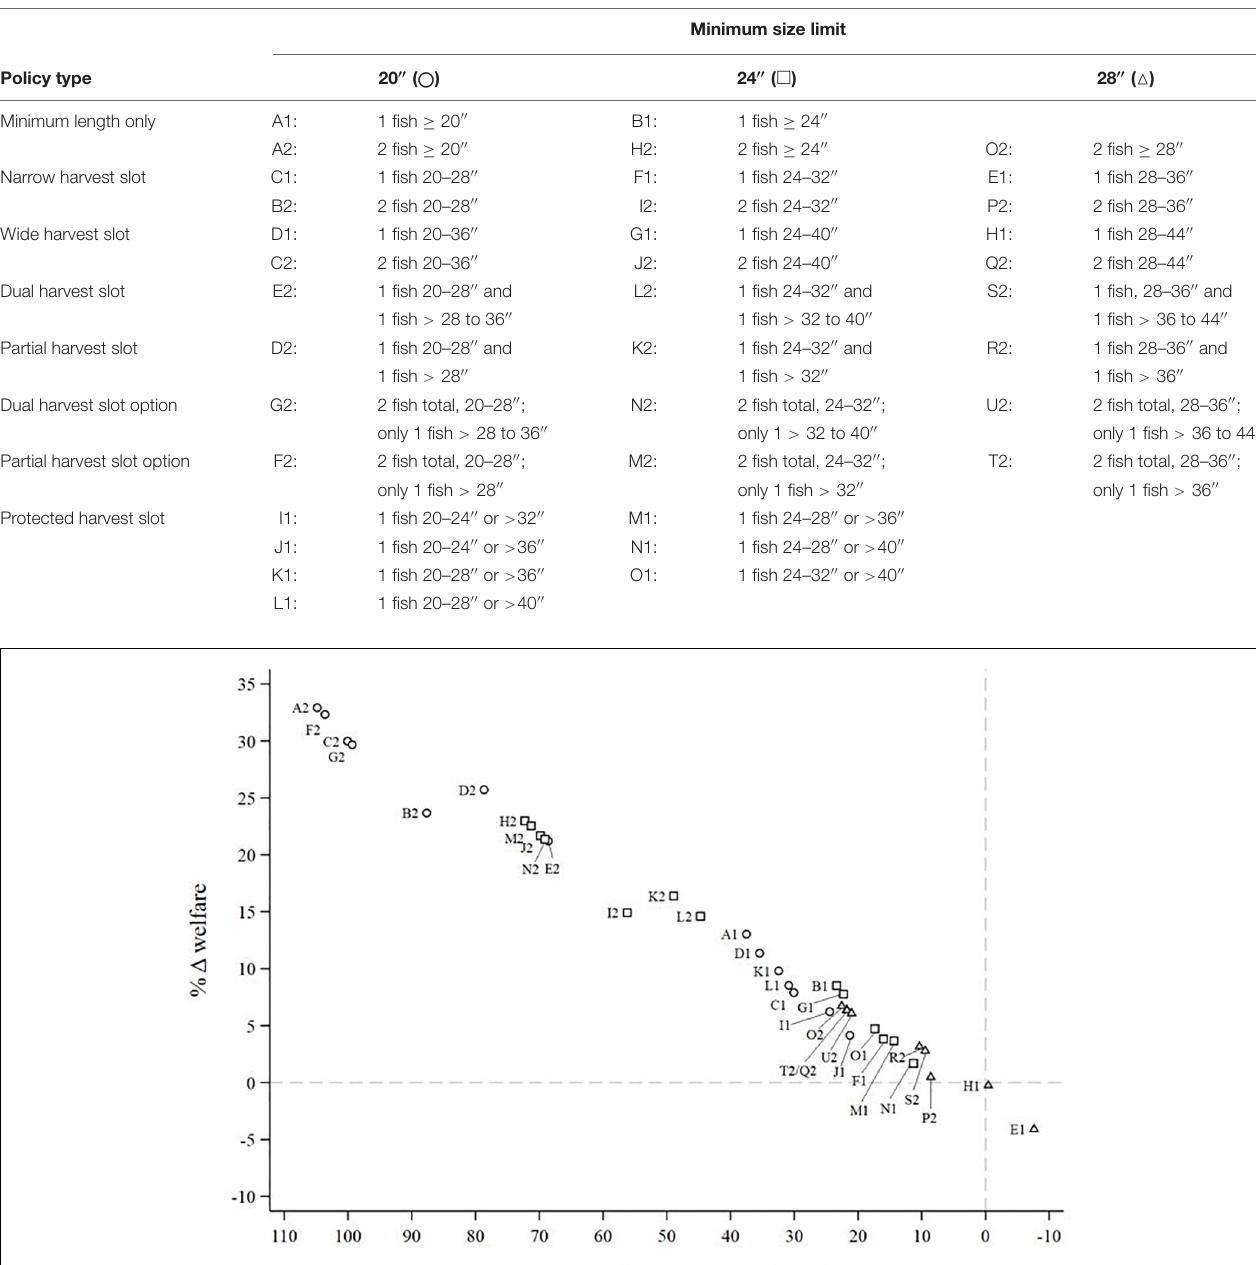
TABLE 6 | Alternative 2015 policies evaluated.